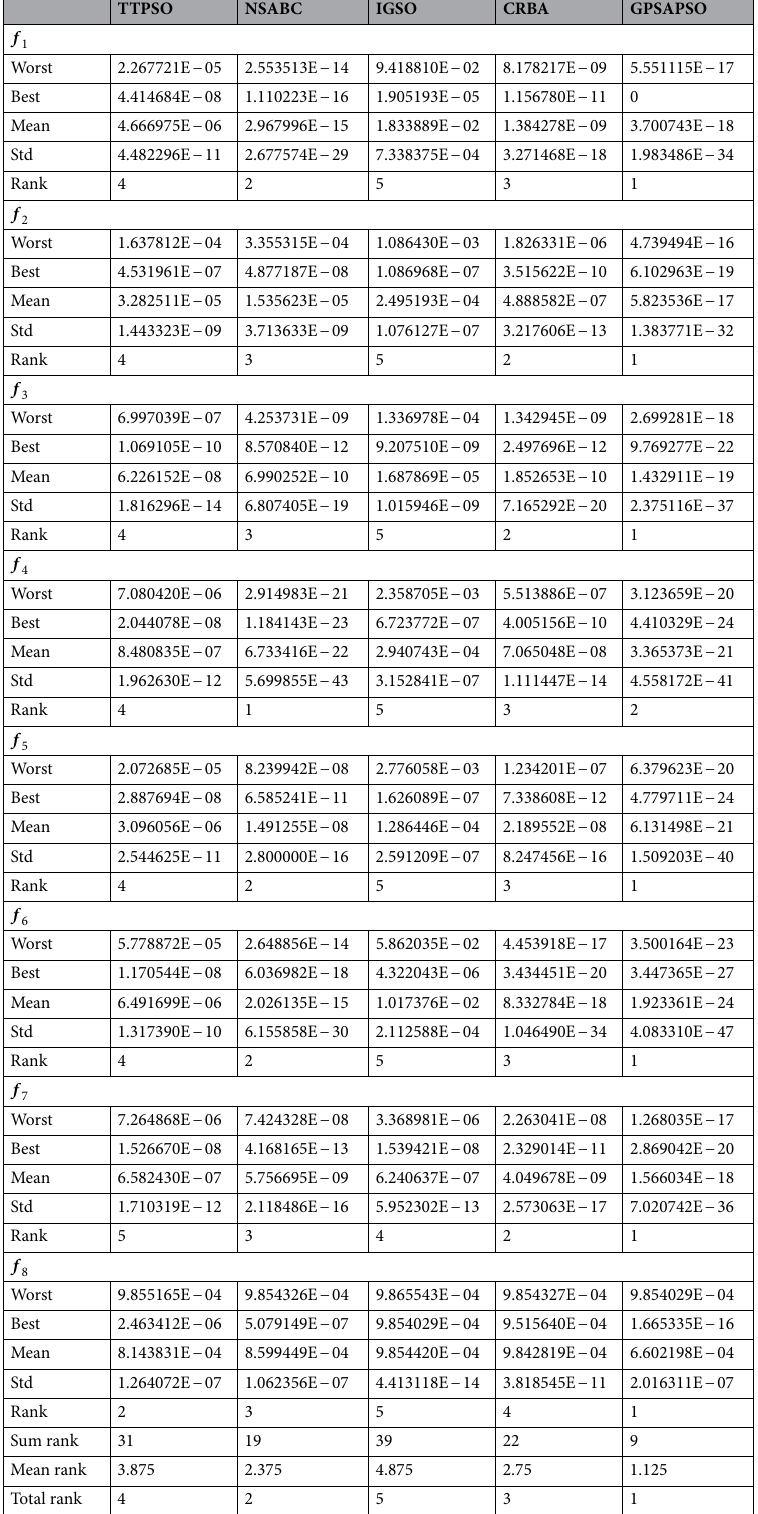
Table 3. Results of 30 runs of low dimensional